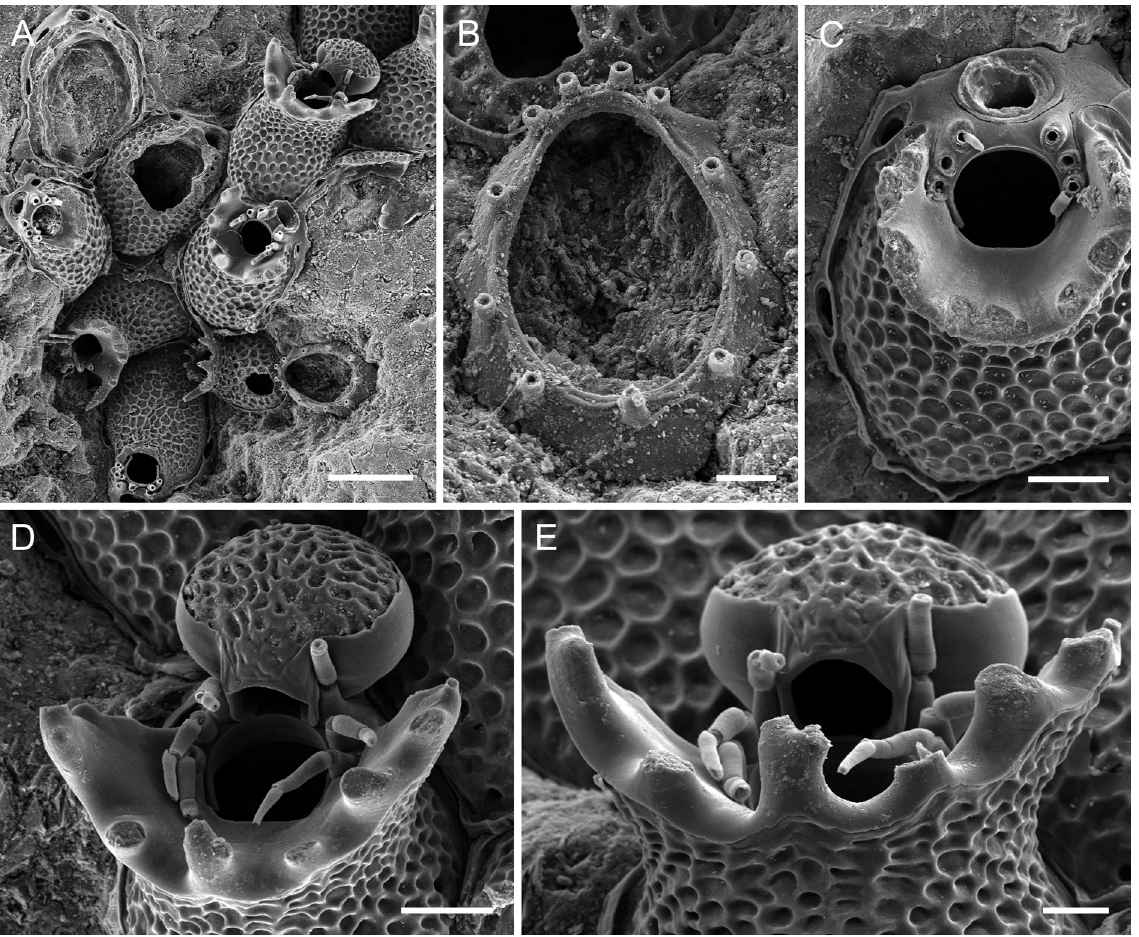
Fig. 10. Atlantisina acantha gen. et sp. nov., Canary Islands, holotype (MNHN-IB-2014-71). A . Overview of the young, yet mature, colony. B . Close-up of ancestrula. C . Autozooid with orifice; note the large distal ooecial pore and the narrow lateral gymnocystal walls with relatively small communication pores. D . Close-up of ooecium and the suboral crest. E . Lateral view of the suboral crest; note that the tips are all broken. Scale bars: A = 300 µm; B, E = 50 µm; C, D = 100 µm.